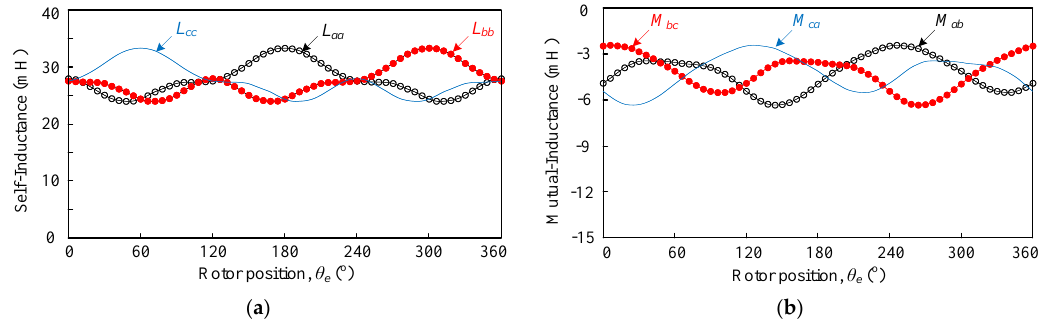
Figure 6. Self- and mutual-inductance of the proposed machine. ( a ) Self-inductance; and ( b ) mutual inductance.